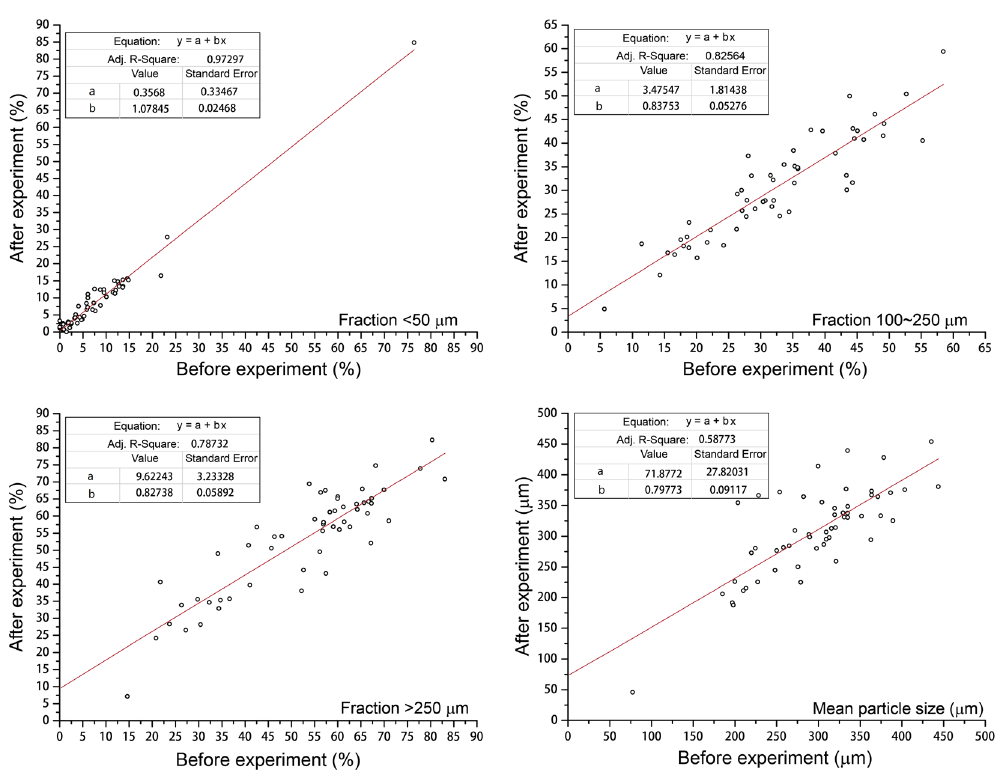
Figure 2. Scatterplots for the relationship of particle size fractions of surface soil before and after wind tunnel